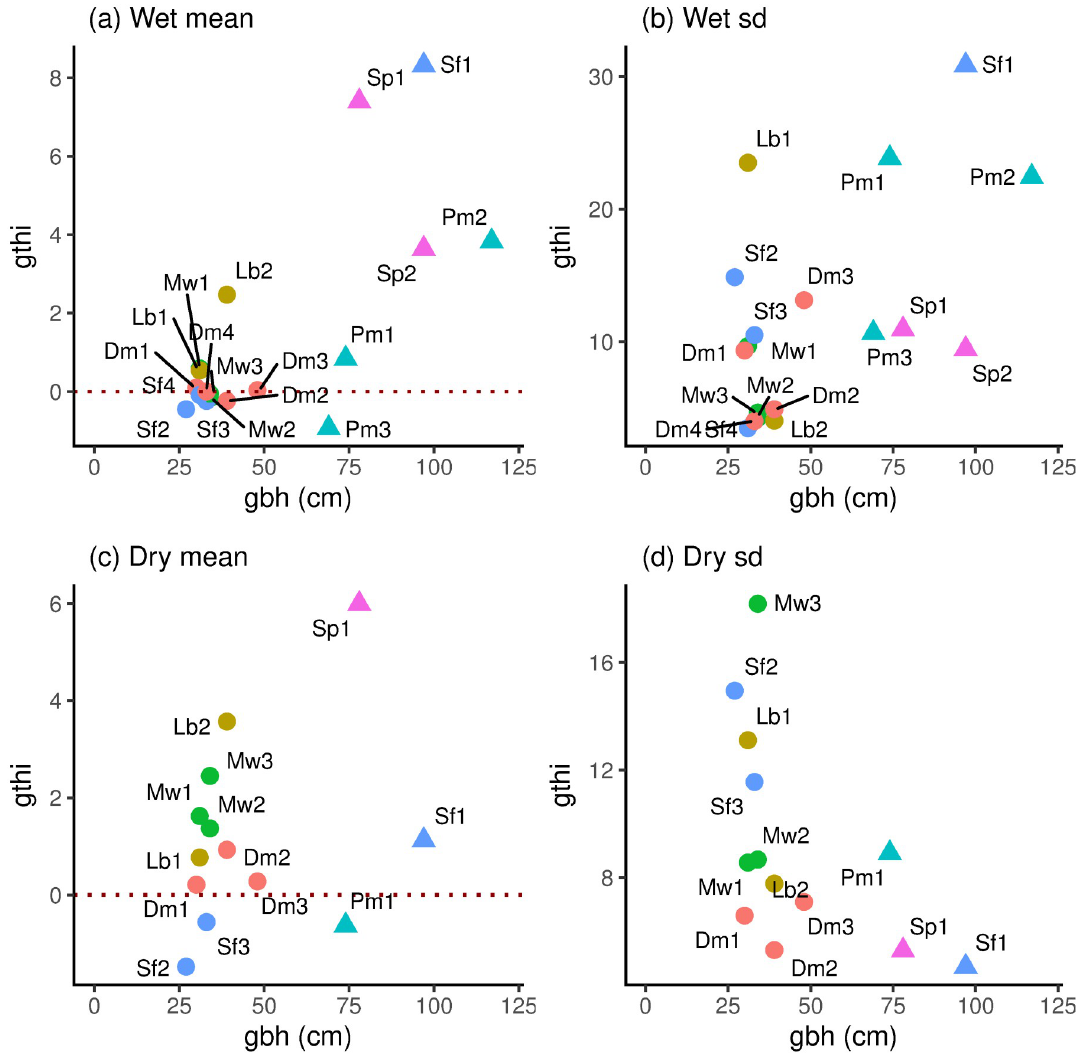
Fig 6. Mean and standard deviation (sd) of daily girth increments ( gthi ) graphed against stem girth ( gbh ). Periods are wet (a, c; n = 18) and dry (b, d; n = 13). Species symbols are colour-coded, their abbreviations as labels with the individuals distinguished by numbers, are listed in Table 2. Size classes: scl 1, circles; 2,